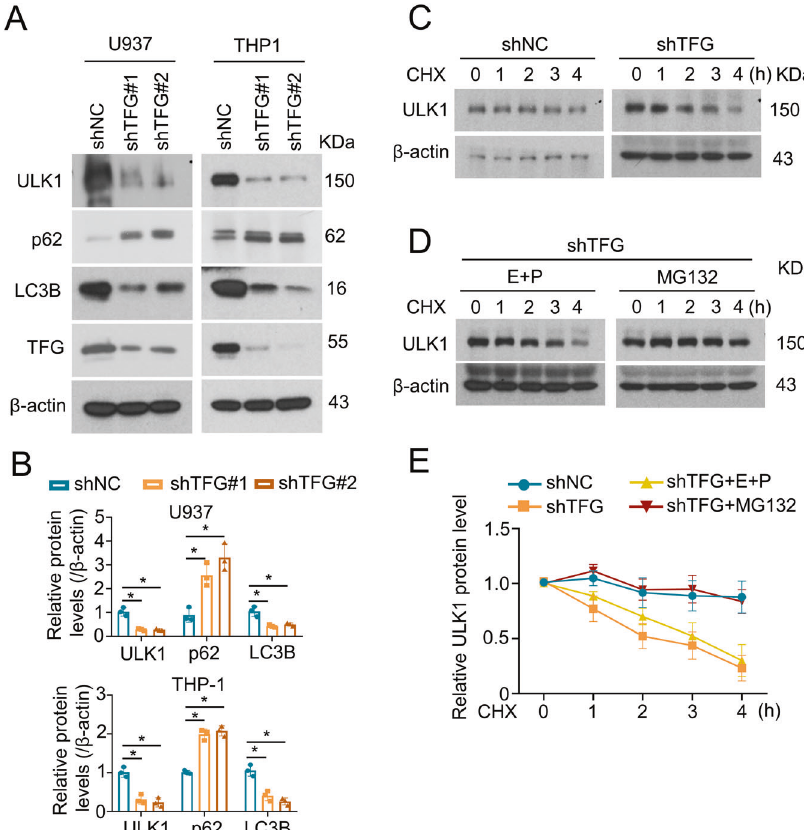
Fig. 2 TFG de fi ciency downregulates autophagy-associated kinase ULK1 and increases p62 protein level. A THP-1 and U937 cells were transduced with shNC, shTFG#1, or shTFG#2. IB were performed to analyze ULK1 and p62 expression levels. B Relative ULK1 and p62 protein levels are shown as bar plots. Bars represent the mean ± s.d. * p < 0.05; n = 3 for each group. C THP-1 cells transduced with shNC or shTFG#2 were treated with CHX (20 μ g/mL) for indicated times and IB assays were performed to analyze ULK1 degradation. D TFG-knockdown THP- 1 cells (shTFG#2 transduced) were pretreated with lysosome inhibitor E64D (10 μ g/mL) + pepstatin A (1 μ g/mL) (E + P) or proteasome inhibitor MG132 (10 μ g/mL) for 2 h. Cells were then treated with CHX (20 μ g/mL) for indicated times and IB assay were performed to analyze ULK1 degradation. E Relative protein levels of ULK1 are shown. Data are shown as mean ± s.d.; n = 3 for each group. Experiments were independently repeated three